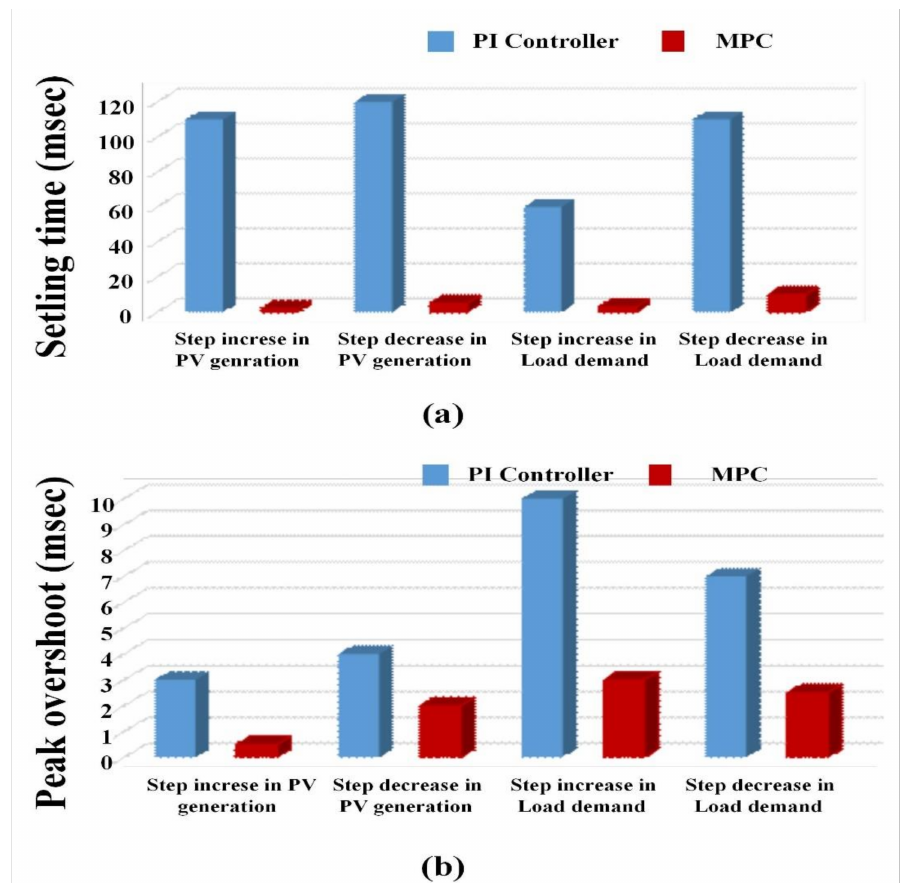
Figure 16. Graphical comparison of PI controller performance over MPC: ( a ) settling time and ( b ) peak overshoot.